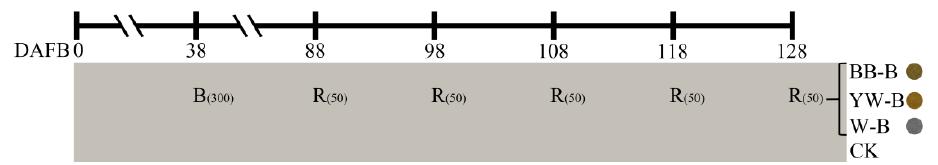
Figure 7. Schematic illustration of the experimental treatment: Samples were collected 128 days after full bloom. B: bagging, R: removal of the bags, DAFB: days after full bloom, BB-B: brown – black bag, YW-B: yellow – white bag, W-B: white bag, CK: no bag.